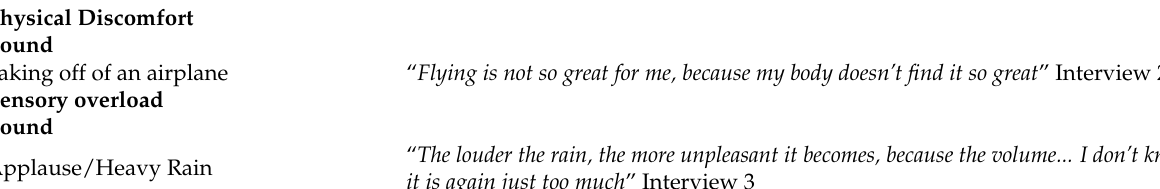
Table 6. Identified other factors and corresponding